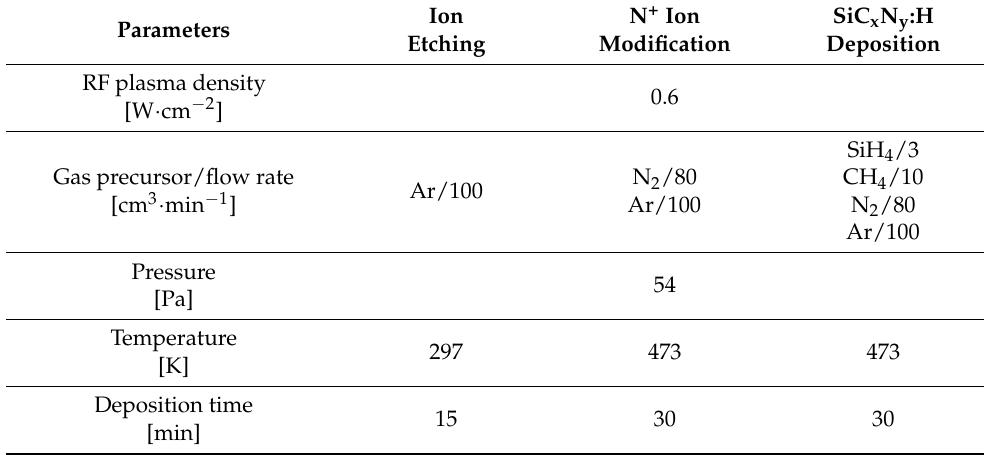
Table 1. Technological parameters chosen for Crofer 22APU steel surface modification by means of the RF CVD